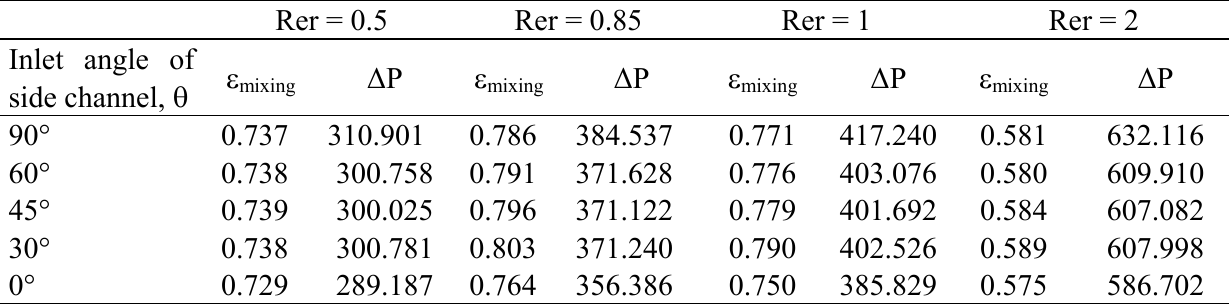
Table 3. Inlet angle of side-channel versus the mixing ( ε Pa) at variations of Reynolds number ratio ranging from Rer = 0.5 to 2 at the case of = Re 2